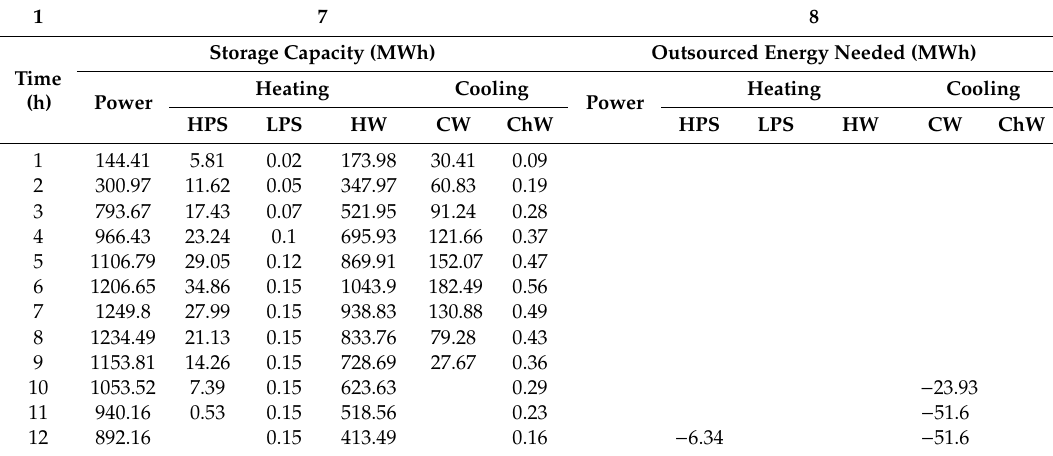
Table A27. TriGenSCT of final trigeneration PWR NPP without integration from time 1 to 12 h.